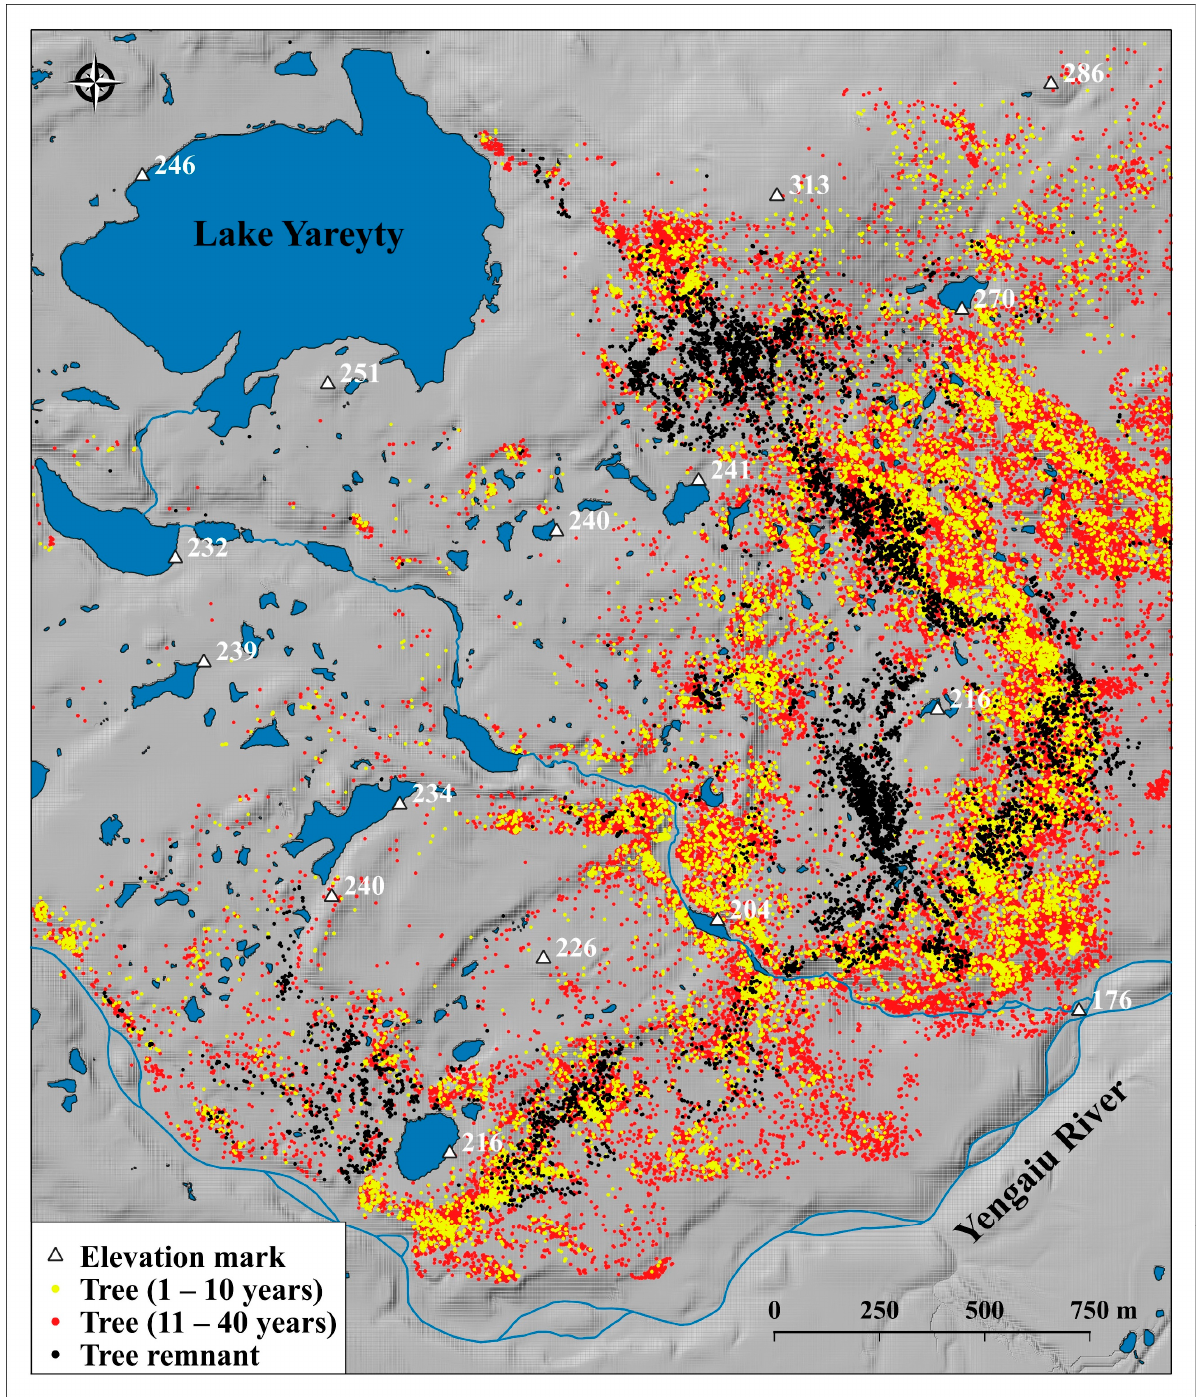
Figure 6. Map of Siberian larch trees belonging to two age categories: 1–10 and 11–40 years of age, showing the locations of trees that were growing in the study area and died during the Little Ice Age.